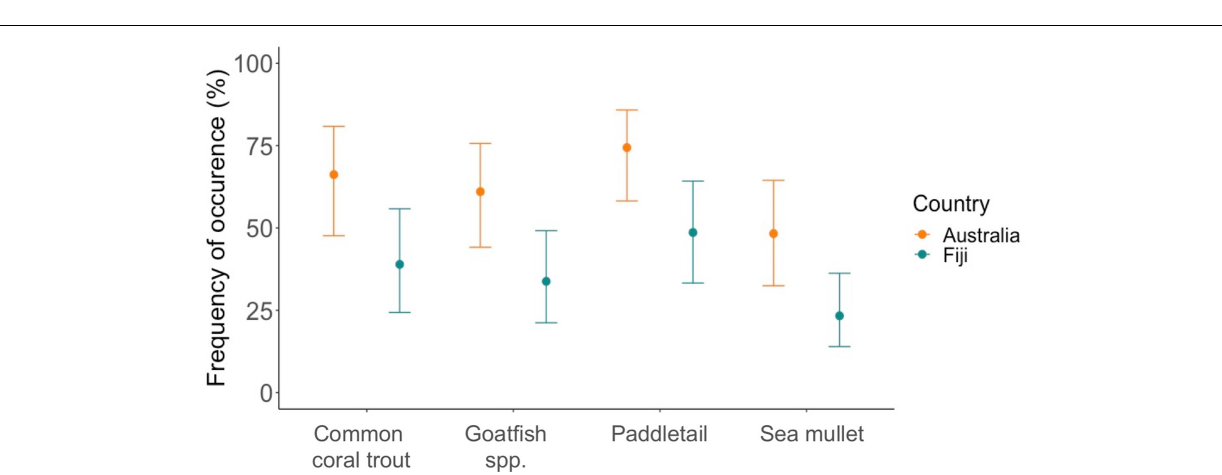
had small numbers of acrylate and polyurethane filaments ( n =